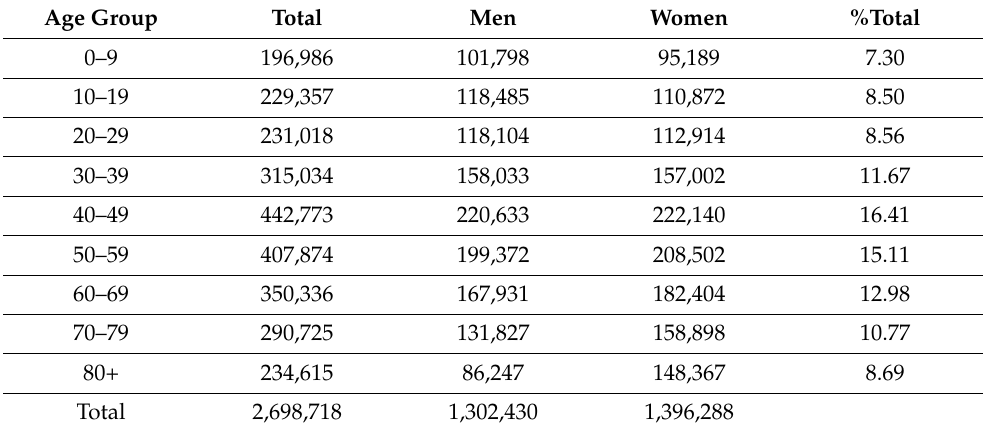
Table 1. Population of Galicia by age groups according to the “Instituto Galego de Estat í stica.” The percentage of each group has been also